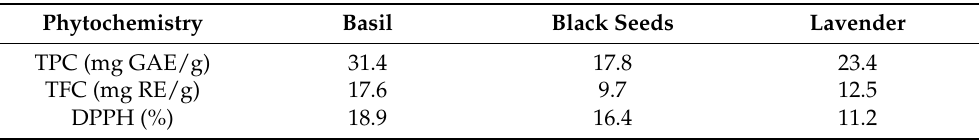
Table 6. Total phenol content (TPC), total flavonoid content (TFC) and free radical scavenging capacity (DPPH) from basil, black seeds and lavender EOs. Phytochemistry Basil Black Seeds